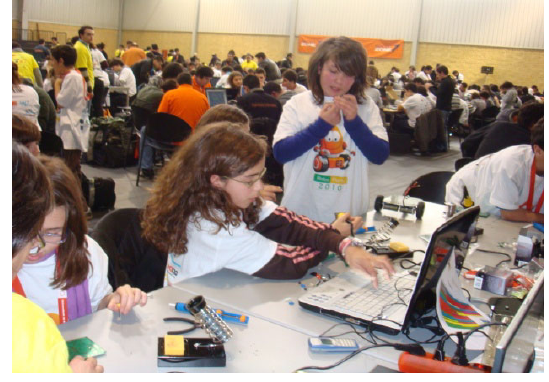
Figure 1. Roboparty event